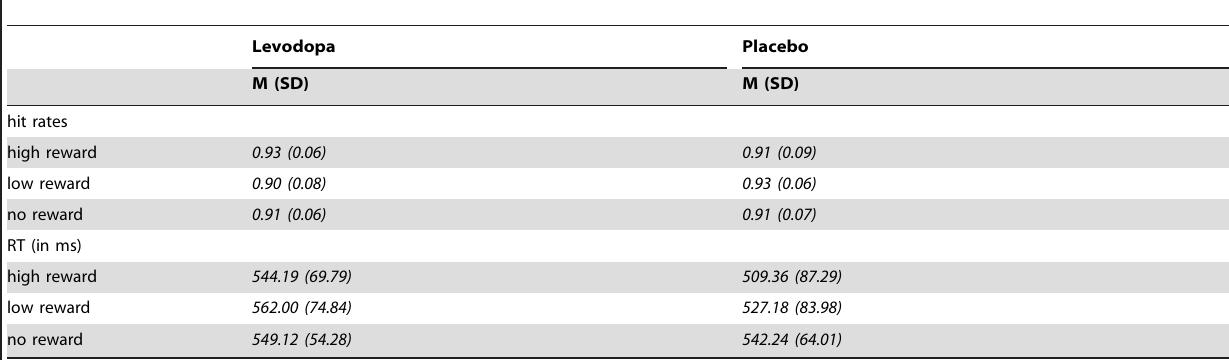
Table 2. Behavioral results